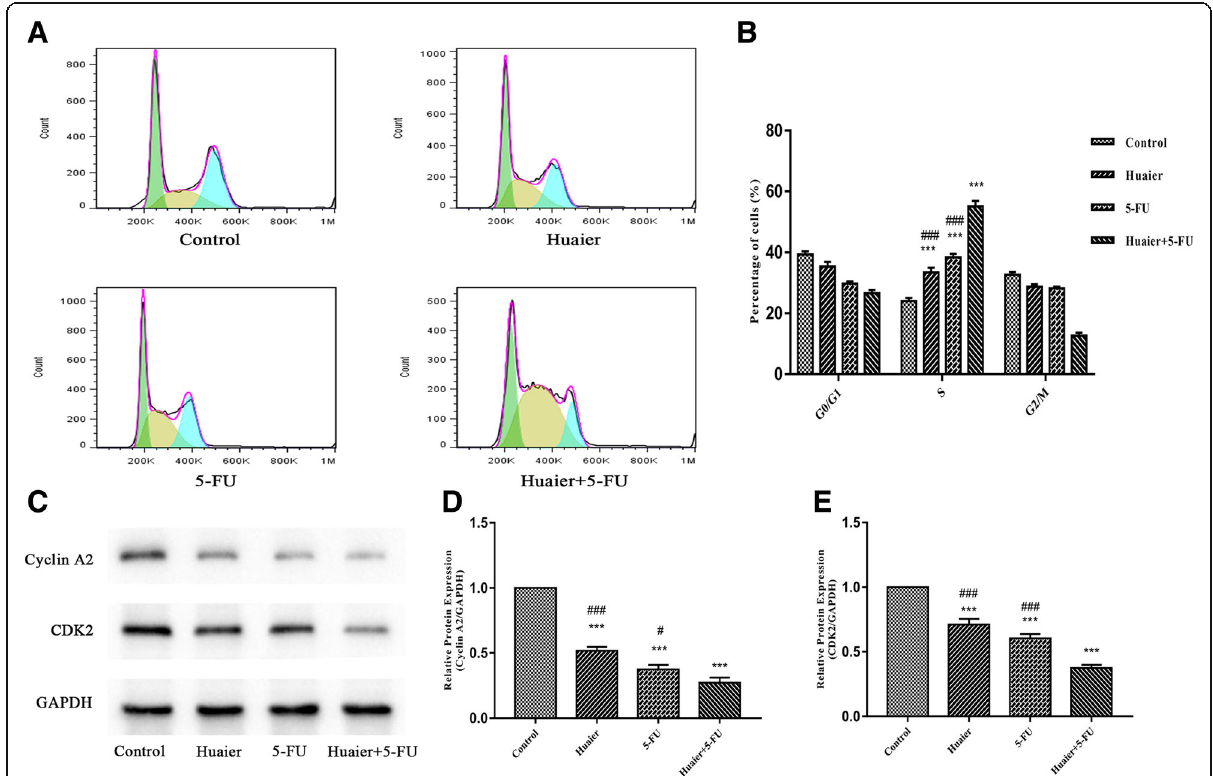
Fig. 3 cell cycle arrest effect of Huaier and 5-FU in single agent or combination on Huh28 cells. a DNA content-based cell cycle of Huh28 cells after 48 h Huaier and 5-FU alone or in combination treatment were analyzed using Flow cytometry. b Percentage of cells in S phases. c , d and e The expression variations of cell cycle related proteins under different treatment conditions were detected using Western blot, and relative optical densities of proteins were analyzed by Image J. All results are expressed as mean ± SD of three independent experiments. * P < 0.05, ** P < 0.01, *** P < 0.001, compared with control group, while # P < 0.05, ## P < 0.01, ### P < 0.001, compared with combination